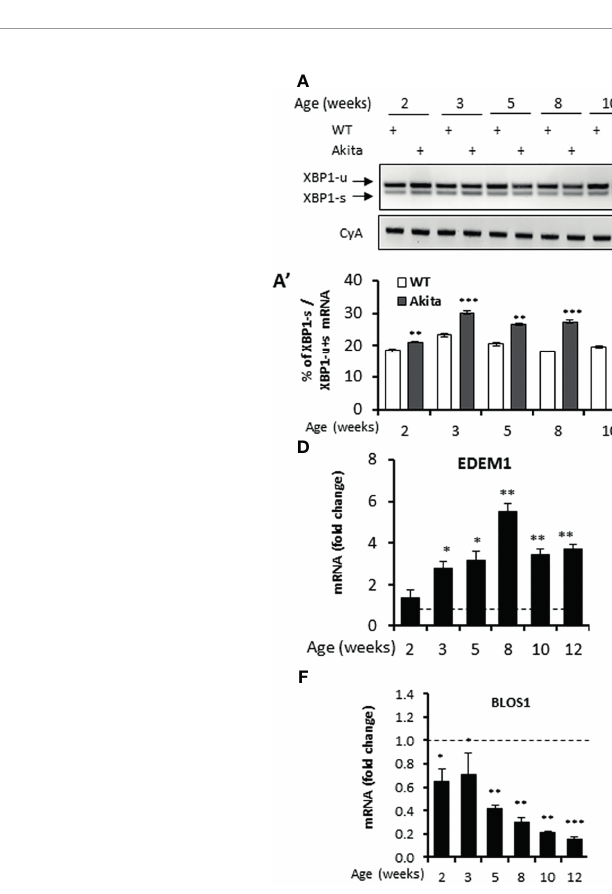
FIGURE 1 | IRE1 a RNase activity up-regulation in islets of Akita mice. (A, A ’ ) . XBP1 mRNA levels were analyzed in islets isolated from Akita mice or age-matched C57B/6 mice at the indicated ages by RT-PCR, and the products were resolved by agarose gel electrophoresis. The full length (unspliced, XBP1-u) and spliced (XBP1-s) forms of XBP1 mRNA were indicated (A) and quanti fi ed (A ’ ) . Cyclophilin A mRNA was used as an internal control. The data shown are representative of 3 independent experiments. (B – G) mRNA levels for indicated genes were analyzed in islets isolated from Akita mice or age-matched C57B/6 mice by qRT-PCR. The results are expressed as the fold change over mRNA levels in respective age-matched controls (represented by the dashed line) and are representative of 3 independent experiments. *P < 0.05, **P < 0.01, and ***P < 0.001. Bars indicate